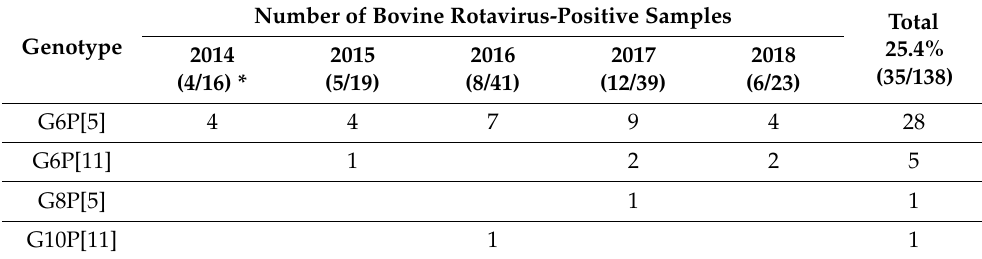
Table 1. Genotyping of 35 BoRVA-positive samples from calf fecal samples collected in South Korea between 2014 and